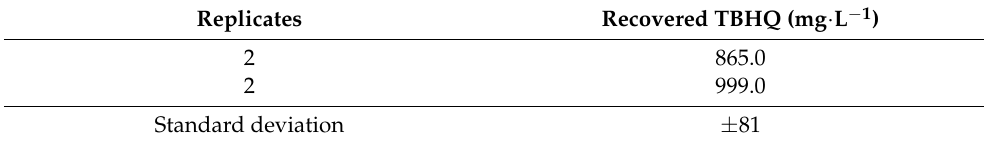
Table 5. TBHQ concentration in FOBL through dispersive microextraction (1044 mg · L − 1 ).